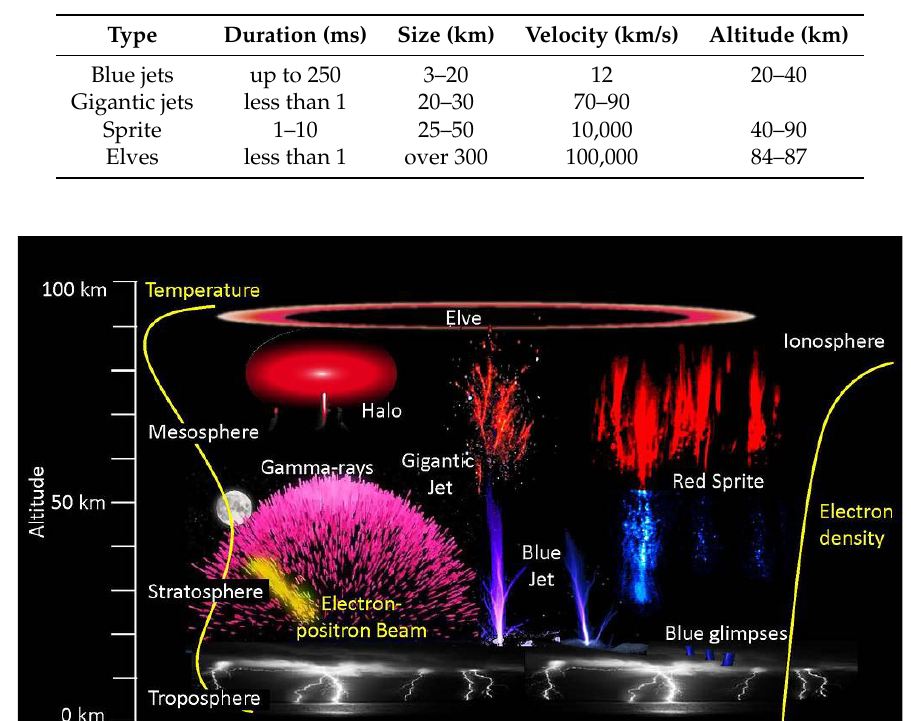
Table 1. The properties of Transient Luminous Events (TLEs) [17–19].